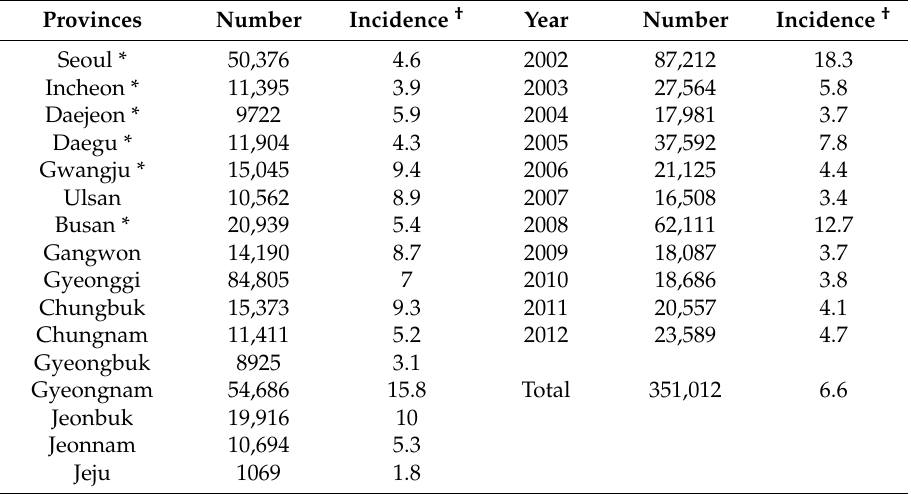
Table 1. General description of aseptic meningitis cases from 2002 to 2012 in Korea. Provinces Number Incidence † Year Number Incidence † Seoul * 50,376 4.6 2002 Incheon * 11,395